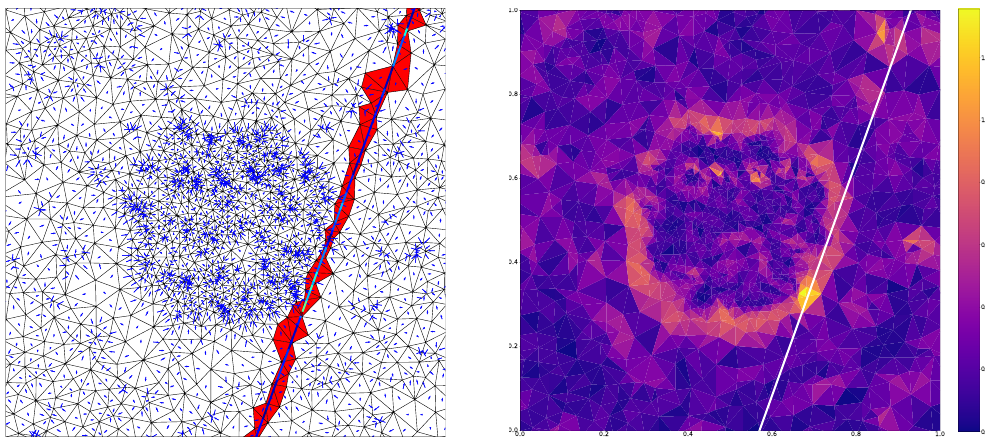
Figure 26 . The line C w with the largest wombling measure in the circular boundary example of section 7.2, overlaid on the Delaunay-averaged gradient vectors h ~G i α (left panel) or on the heatmap of their magnitudes (right